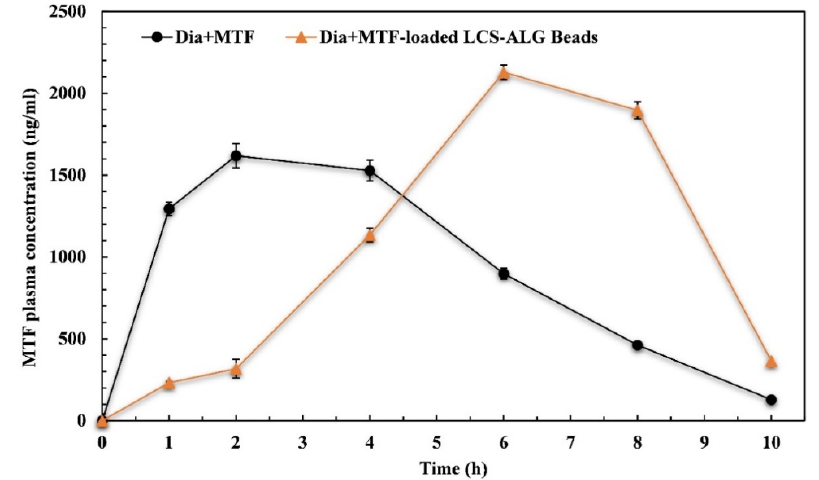
Figure 7. Mean plasma MTF concentration-time profile for pure MTF and MTF-loaded LCS-ALG beads following single oral administration equivalent to 25 mg/kg bw of MTF to STZ-induced diabetic Sprague-Dawley rats. Data shown as mean ± SE, ( n = 6). Solid lines are guides to the eye. Table 2. PK parameters of MTF in plasma following oral administration of single dose of pure MTF and the optimized MTF-loaded LCS-ALG beads equivalent to 25 mg/kg bw. Pharmacokinetic Parameter Pure MTF MTF-Loaded LCS-ALG